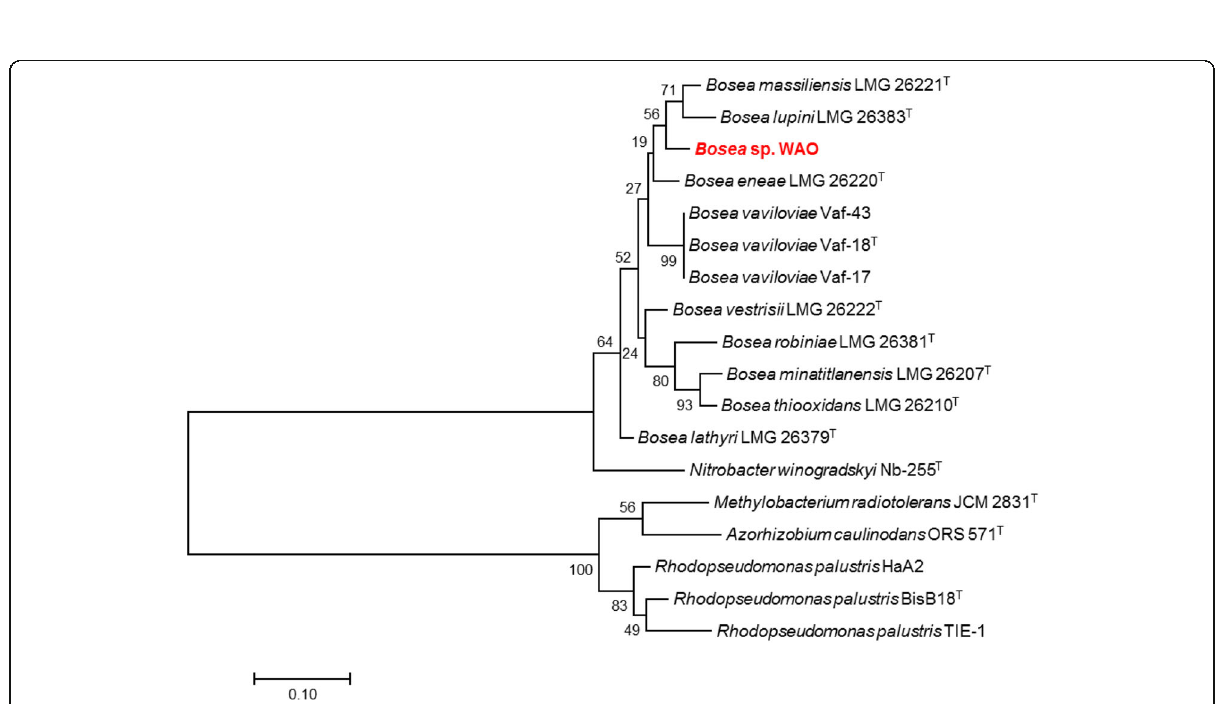
Fig. 3 Molecular Phylogenetic analysis by Maximum Likelihood method of the aptD gene. The evolutionary history was inferred by using the Maximum Likelihood method based on the Tamura-Nei model [19]. A Phylogenetic tree highlighting the position of Bosea sp. WAO relative to the other Bosea spp. and related organisms based on the aptD gene. The tree with the highest log likelihood ( − 2412.0185) is shown. The percentage of trees in which the associated taxa clustered together is shown next to the branches. Initial tree(s) for the heuristic search were obtained automatically by applying Neighbor-Join and BioNJ algorithms to a matrix of pairwise distances estimated using the Maximum Composite Likelihood (MCL) approach, and then selecting the topology with superior log likelihood value. The tree is drawn to scale, with branch lengths measured in the number of substitutions per site. The analysis involved 18 nucleotide sequences. All positions containing gaps and missing data were eliminated. There were a total of 361 positions in the final dataset. Evolutionary analyses were conducted in MEGA7 [20]. Type strains are indicated with a superscript